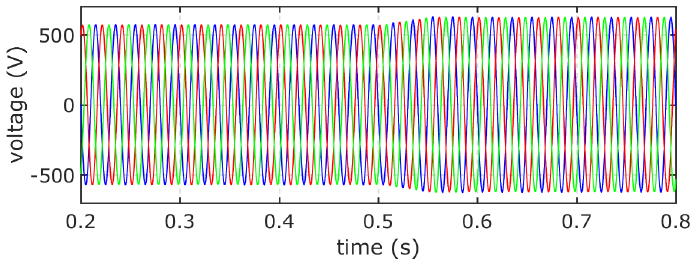
Figure 16. Stator voltage response to a stator flux step at constant wind speed and load (phase a-red; phase b-green; phase c-blue).